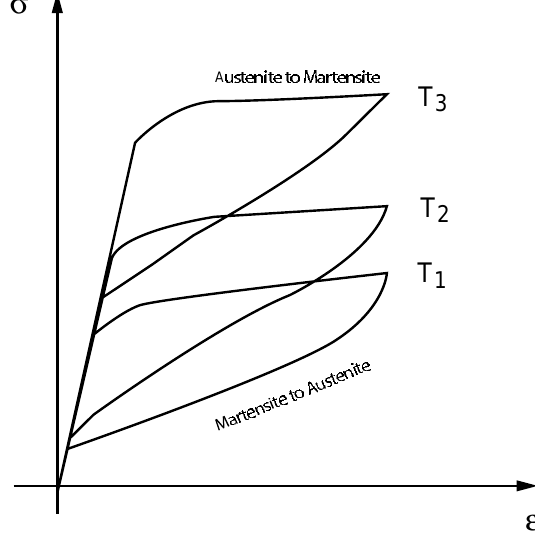
Fig. 4. Isothermal mechanical behavior of the shape memory alloy, A s < T 1 < T 2 < T 3 .